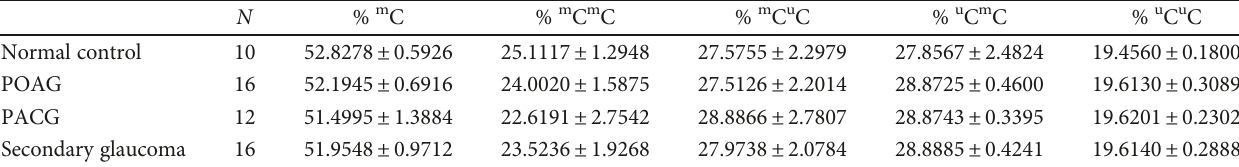
Table 3: Alu methylation levels in glaucoma eyes and control